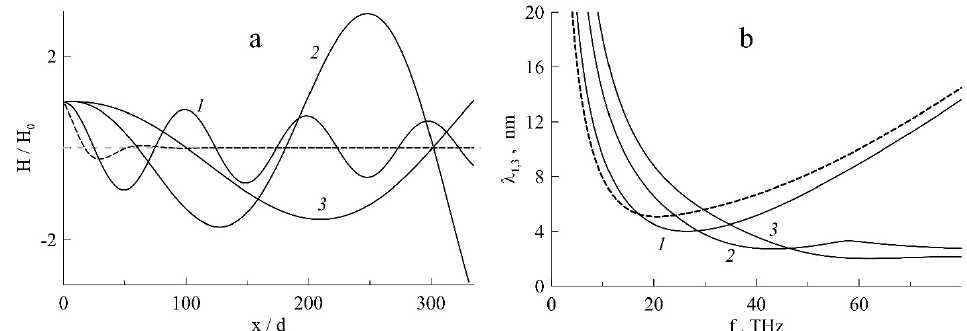
Figure 6. Dependence of the wave amplitude on the longitudinal coordinate at the frequency of 20 THz ( a ) and frequency dependence of the surface plasmon-polariton depth ( b ) for a structure with inverted graphene; µ = 0;0.02;0.06;0.10 eV (dashed curve and curves